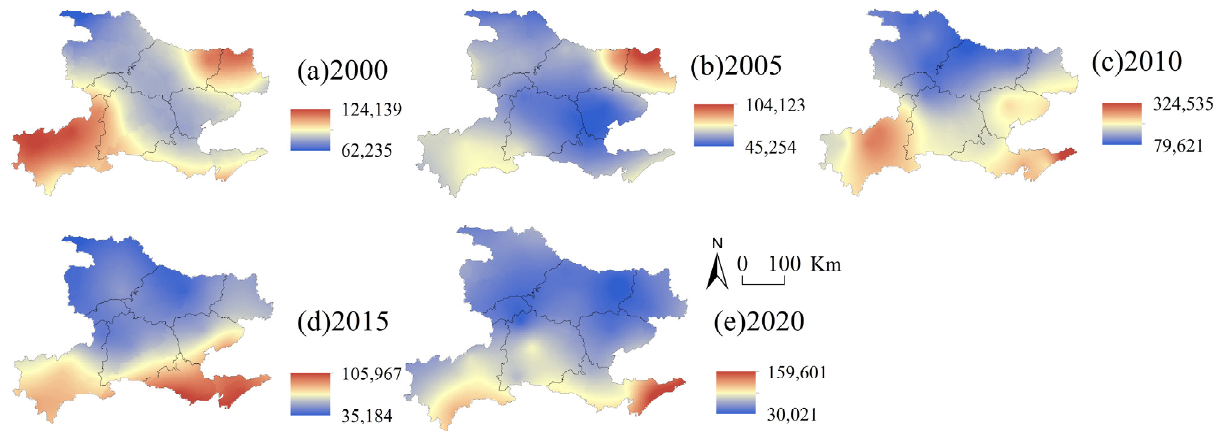
Figure 13. Rainfall erosivity map for western Hubei Province in ( a ) 2000, ( b ) 2005, ( c ) 2010, ( d ) 2015, ( e ) 2020.